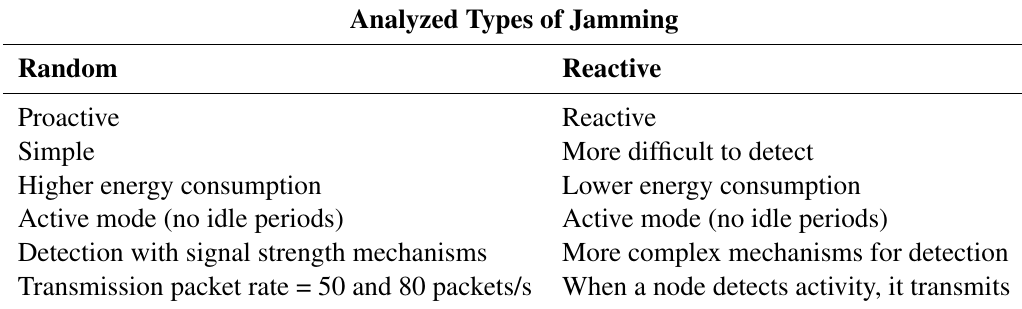
Table 1. Comparative study of jamming: random and